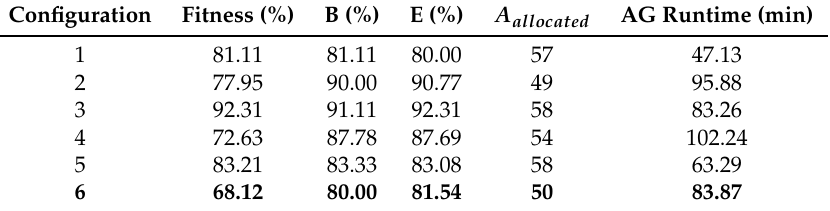
Table 6. Results obtained when simulating a 10 kA lightning discharge at buses B 35 , B 42 and B 36